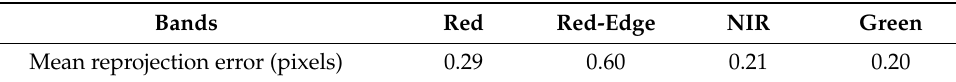
Figure 13. Reprojection error between the distorted and undistorted image for NIR band. The x - and y -axis represent the number of images and mean errors in pixels, respectively. Table 3. Mean reprojection error between the distorted and undistorted image for different multi- spectral